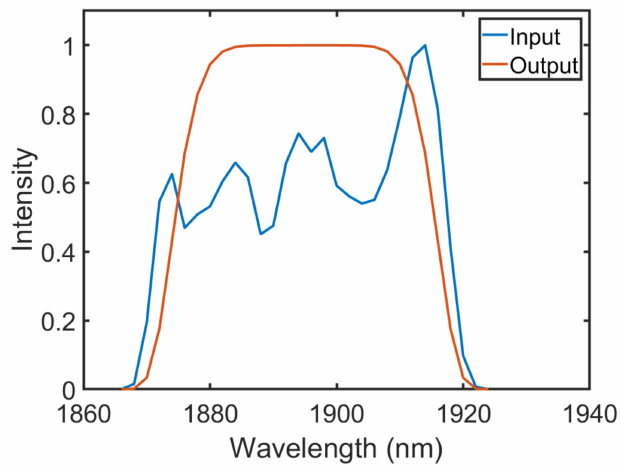
Figure 4. Simulated input and output spectral shapes of main amplifier when operating at 100 Hz. The output is a 41 nm FWHM 8-th order super-Gaussian. The shape of the input spectrum was adjusted (sculpted) so that the resultant output shape would be an 8-th order